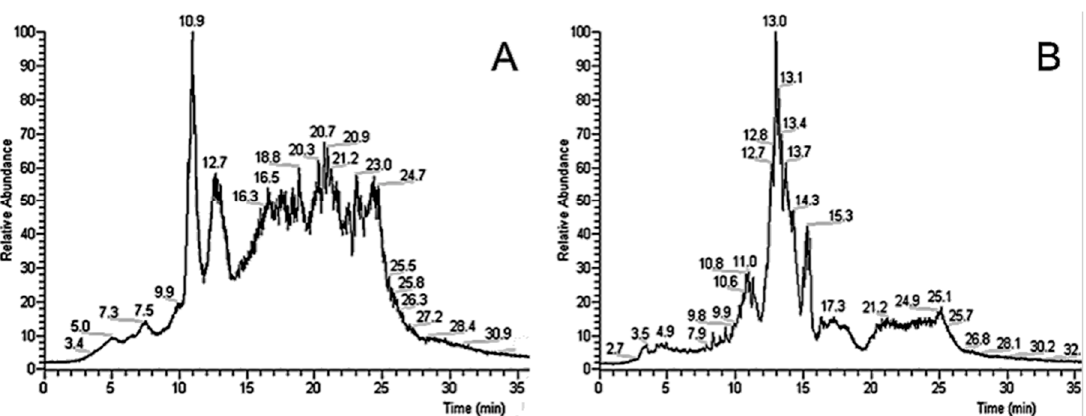
Figure 2. OLE–LC–MS analysis of sunflower seeds in quaternary gradient in ( A ) SiGO-C18ec (100 × 0.5, 5 µ m FPP), at 0.2 mL/min and ( B ) C18 (50 × 2.1 mm, 1.7 µ m SPP), at 0.3 mL/min. TIC chromatograms are in m/z range of 100 to 800. From 100% of H 2 O (0.1% FA) to 100% of methanol (0.1% FA) in 10 min, followed by a linear gradient to 90% of chloroform and 10% of methanol (0.1% FA) in 10 min, and the last stem of a linear gradient of 90% of 2-propanol and 10% of methanol (0.1% FA) in 10 min, followed by more 5 min of isocratic 90% of 2-propanol and 10% of methanol (0.1% FA) at 30 ◦